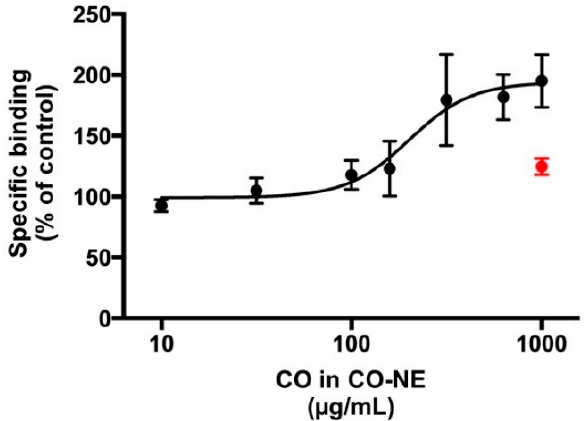
Figure 7. Enhancement of [ 3 H]muscimol binding in the presence of CO in CO-NE. The red point denotes the CO-NE vehicle at the highest concentration tested, indicating that this did not per se significantly increase the total binding levels. Data are presented as mean percentage of specific binding ± SD for one representative curve, which was confirmed in three additional, independent experiments. Collected data for four independent repetitions gave an EC 50 (pEC 50 ± S.E.M.) of 175 µg/mL (3.78 ± 0.09) and an average maximal binding of 189.6 ± 4.5%.